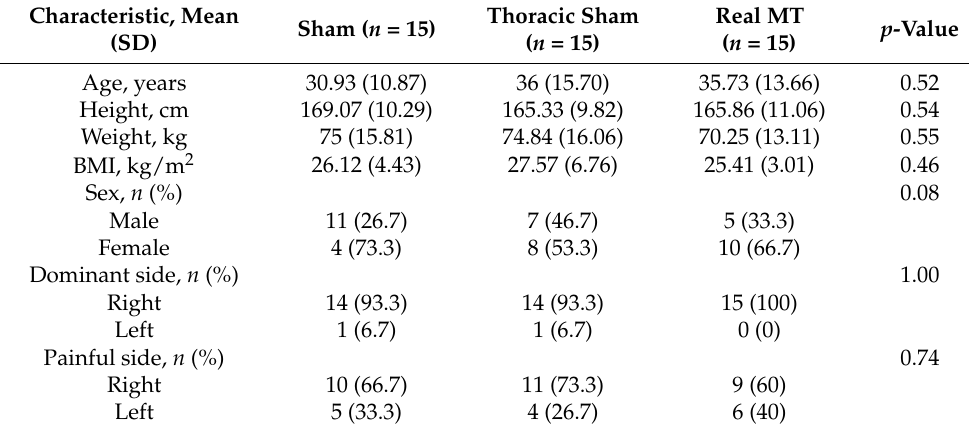
Table 1. Baseline characteristics of the subjects ( n =